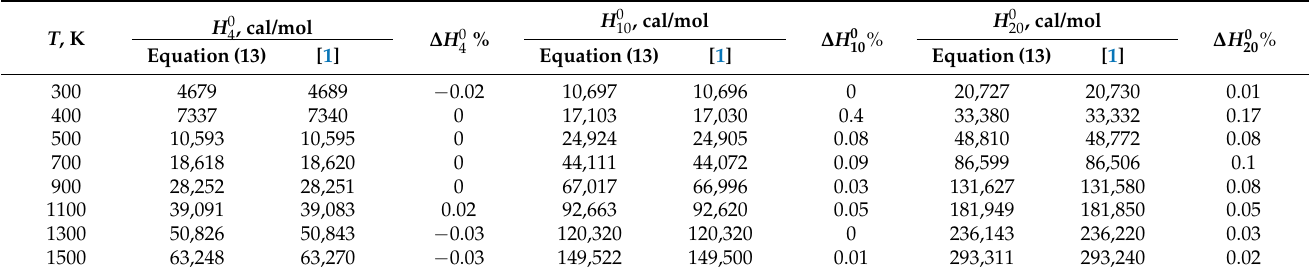
Table 6. Accuracy of Equation (13) for calculating H 0 n ( T ) with n = 4, 10, and